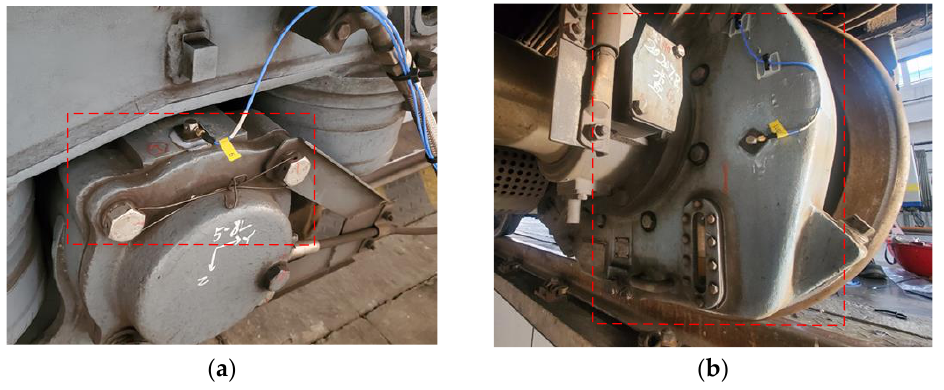
Figure 2. Sensor layout in the field test. ( a ) Layout of sensors on axle box, and the red circle indicates that the axle box; ( b ) Layout of sensors on gearbox, and the red circle indicates that the gearbox.